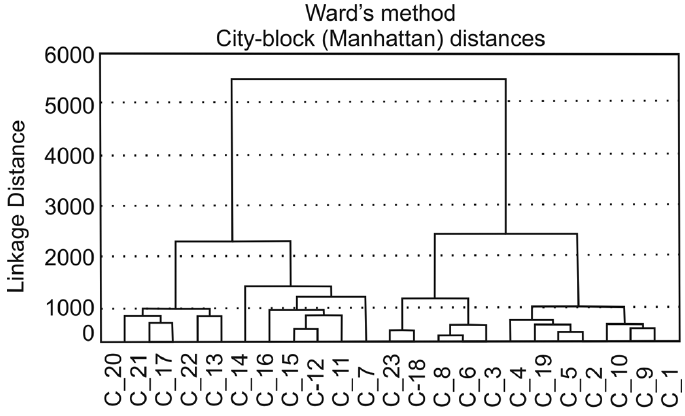
Fig. 9 – Clustering of sampling points considering the 9 variables from Table